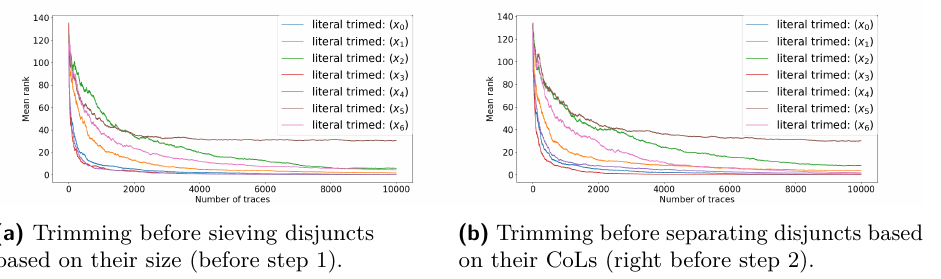
Figure 21: Guessing entropy for TTSCA big on ASCADv1_f before step 1 and right before step 2 of proposed